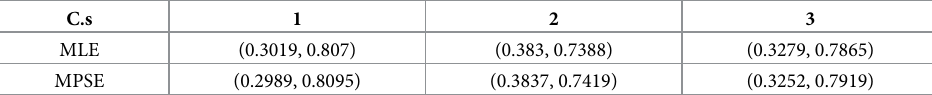
Table 14. Bootstrap confidence intervals for the considered estimates of θ for example 1.